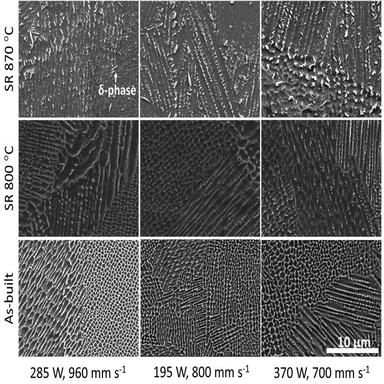
SEM micrographs of etched samples for three conditions and three laser power and laser scan speed combinations default, lowest power over speed ratio, and highest power over speed ratio. The rows are the three conditions, and the columns are the three power-speed combinations.